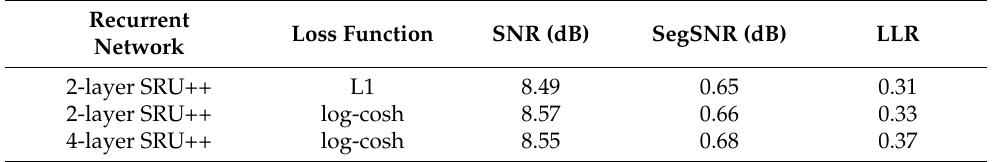
Table 3. Comparison of the model performance with 2-layer, 4-layer SRU++, and different loss functions. The training batch size was 56 and the epoch was 50.